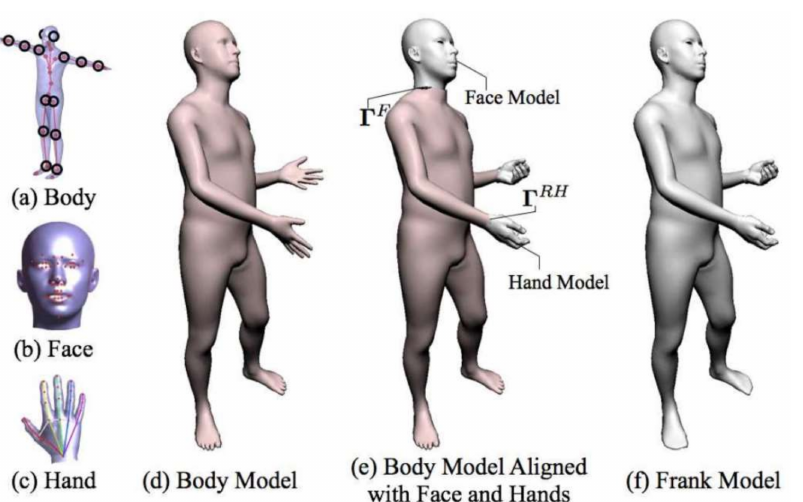
Figure 7. A mesh model is used to fit with point cloud of human body. ( a ) SMPL model; ( b ) Face- Warehouse model; and ( c ) artist-defined hand model. In ( a – c ), the red dots represent 3D positions of the corresponding keypoints reconstructed by detectors; ( d ) Body model; ( e ) Face and hand models are aligned with the corresponding parts of the body model; and ( f ) The whole Frank model. Figure from